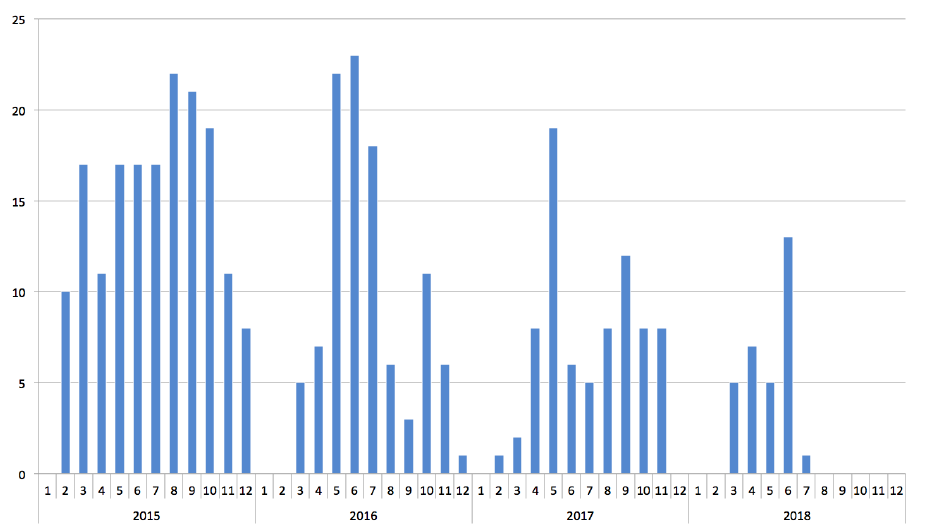
Fig. 5. Number of night-time calls to the CDAQ on-call expert per month from 2015 to 2018. Data provided by the CERN IT/CS